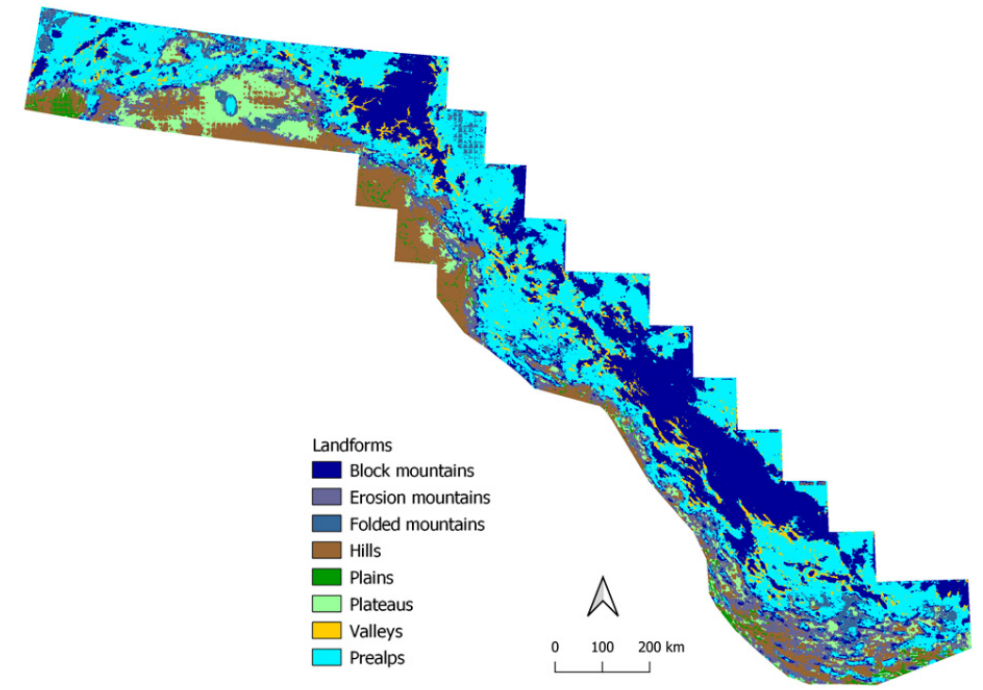
Figure 11. Predictions for the Zagros Mountains. The Carpathians are a mountain range in the shape of an arc in the Central and East- ern Europe. It is lower compared to the Alps and has its highest peak of 2655 m in the norther part [26]. Its predictions (Figure 12) appear to change with elevation a lot, and most of the mountainous area are defined as erosion mountains, respectively, due to heights and similar rounded shape. The squared patterns over the plains are caused by tiling, and these artefacts occur, because the model did not “see” large areas of plains in the input dataset.